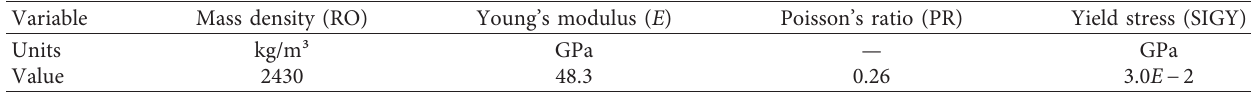
Table 4: Rock material parameters.